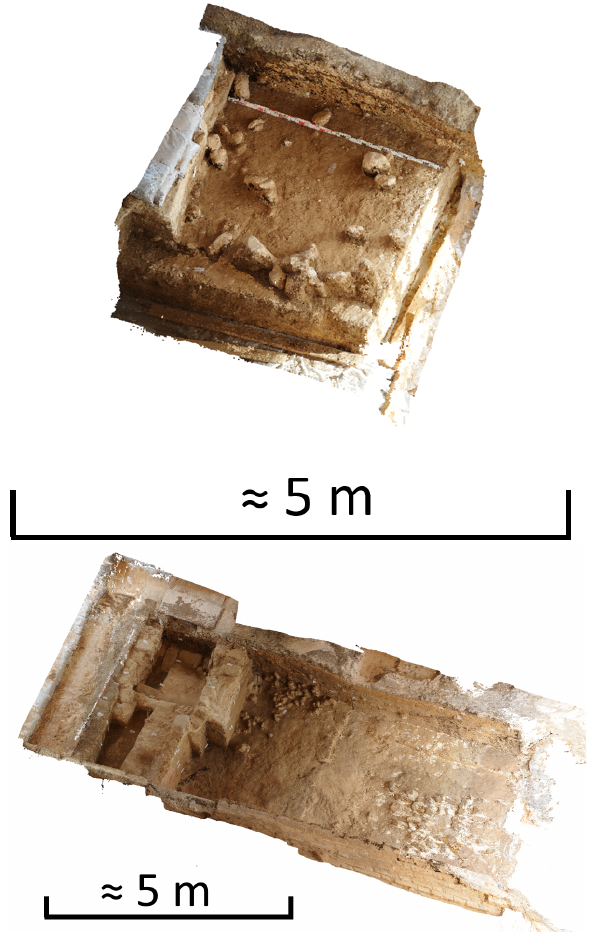
Figure 3 : two point clouds requiring 20 images at the top and 405 at the